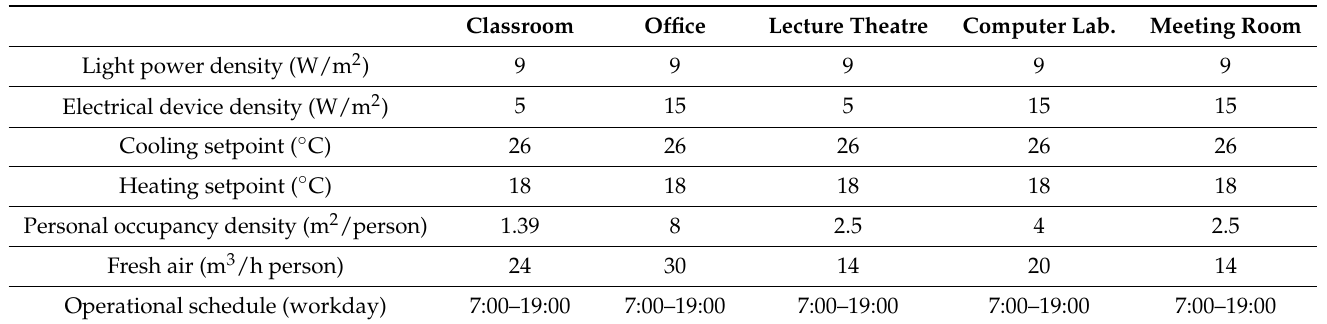
Table 3. Main functional zone design parameters of conditioned